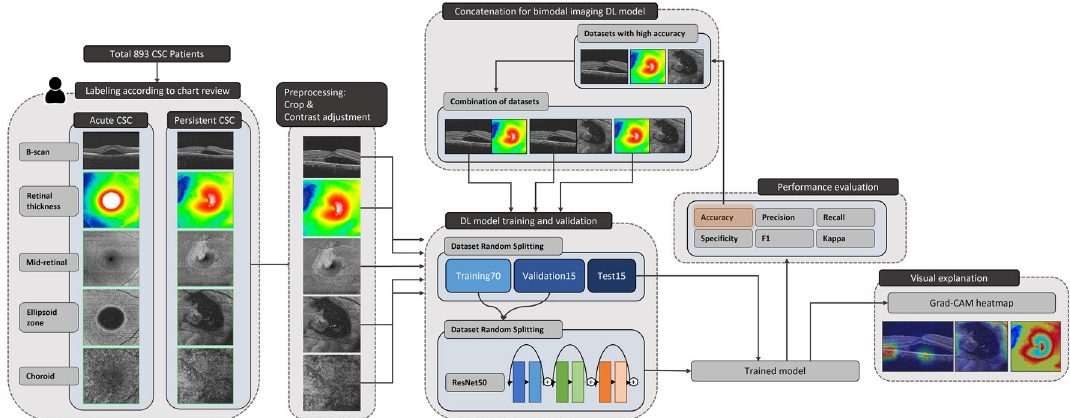
Figure 4. A schematic of deep learning (DL) model training, validation, and performance assessment for prognosis of central serous chorioretinopathy (CSC) using optical coherence tomography (OCT) image sets. Baseline horizontal OCT B-scan crossing the fovea and en face images of retinal thickness, mid-retinal, ellipsoid zone (EZ), and choroidal layers were saved as a JPEG (.jpg) file from each patient and labeled as acute or persistent disease status at 6 months from baseline. The collected images underwent resizing and preprocessing of crop and contrast adjustment. Then, a deep learning model using ResNet50 architecture was trained and validated to predict the impact on the training and validation sets. Next, a performance evaluation on the test set was carried out. Visual explanation analysis was performed using a heatmap generated with gradient-weighted class activation mapping (Grad-CAM). Image sets with high accuracy were concatenated for bimodal imaging model